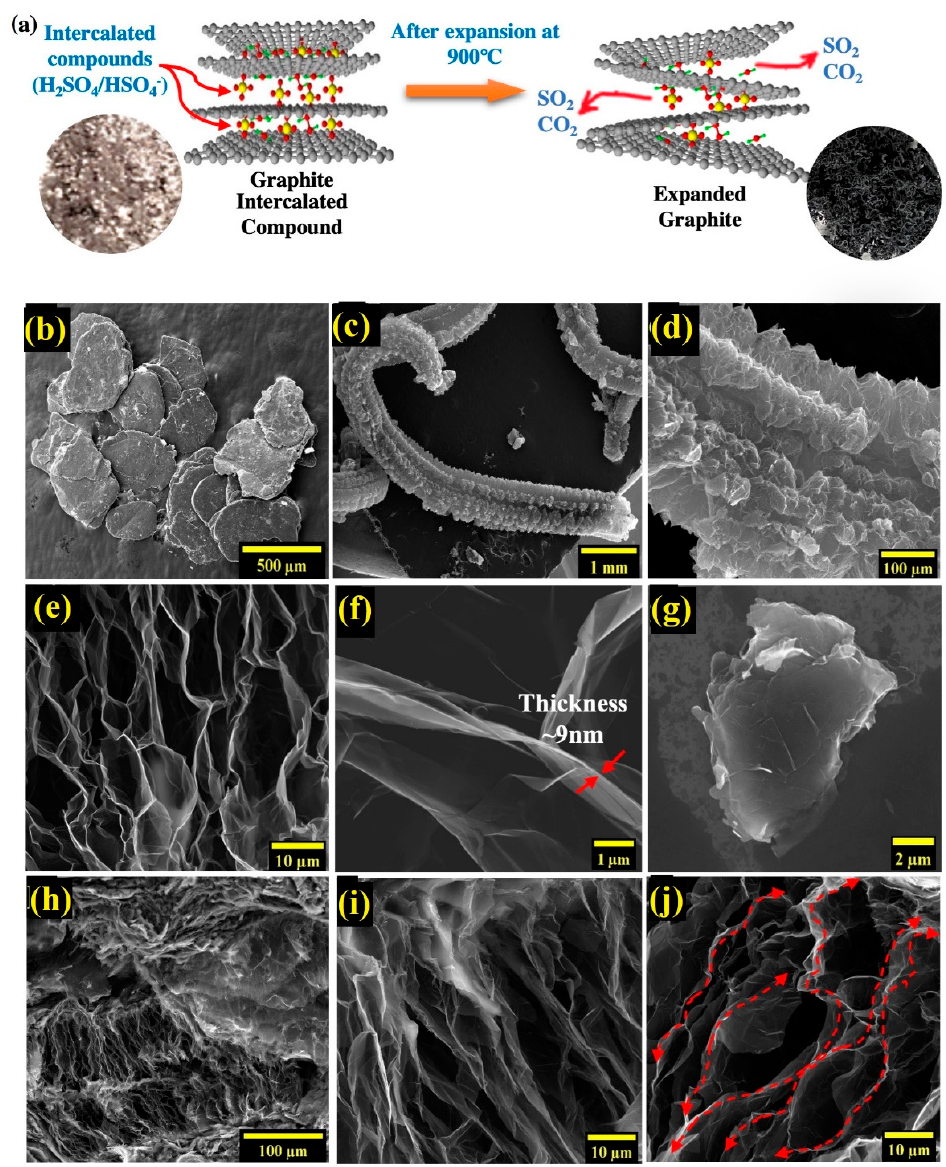
Figure 1. ( a ) Schematic illustration of expanded graphite from graphite intercalated compounds through thermal expansion. SEM image of ( b ) GIC, ( c ) expanded graphite after thermal expansion. High − resolution FE − ESEM images of EG at magnification of ( d ) 100×, ( e ) 1500×, ( f ) 12,000×, ( g ) FE − ESEM images of 60 nm graphene nanoplatelet. FE − ESEM images of EG/PEID composite at ( h ) 350×, ( i , j ) 3500× .